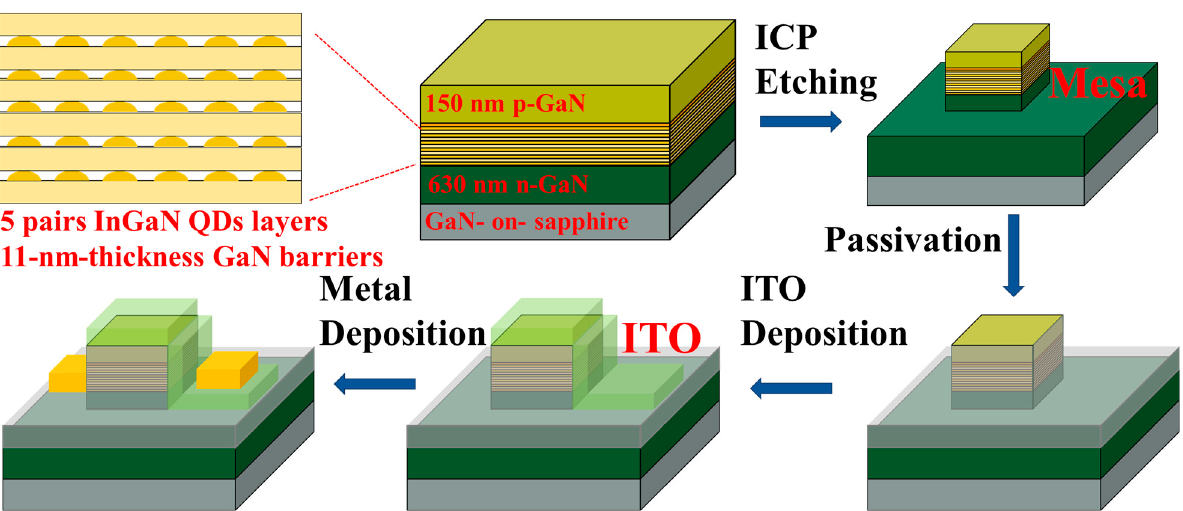
Figure 1. Schematic diagram of the QD micro-LED structure and the processing flowcharts of the QD micro-LED.